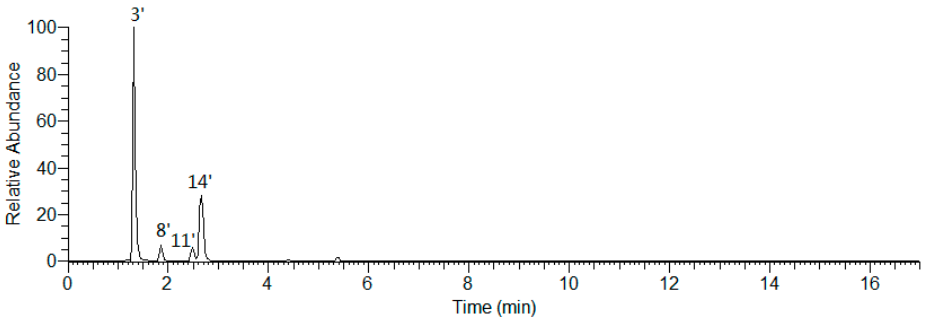
Figure 11. The EIC of the m/z 801.17201.